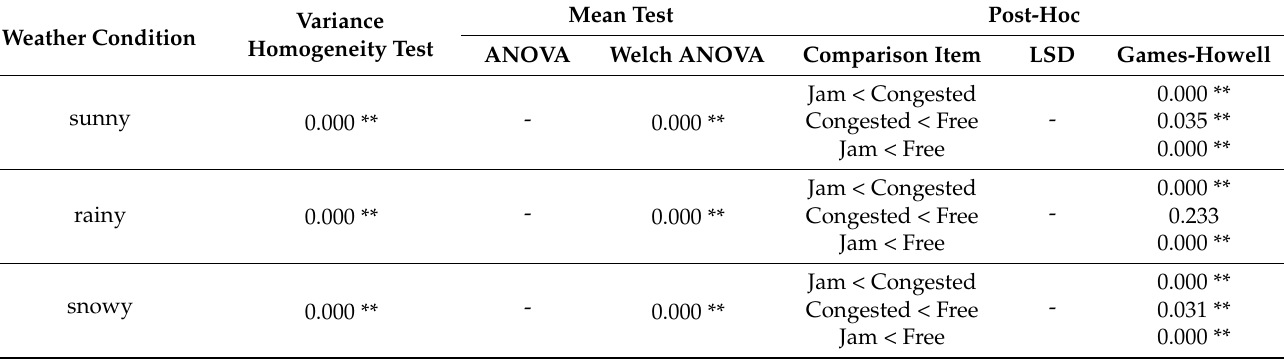
Table 9. The significance test of the influence of traffic flow conditions on the standard deviation of time